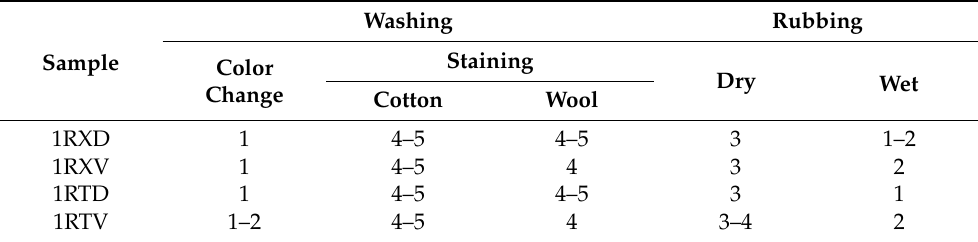
Table 6. Results of the washing and rubbing fastness tests of the pre-mordanted samples after dyeing with common madder.